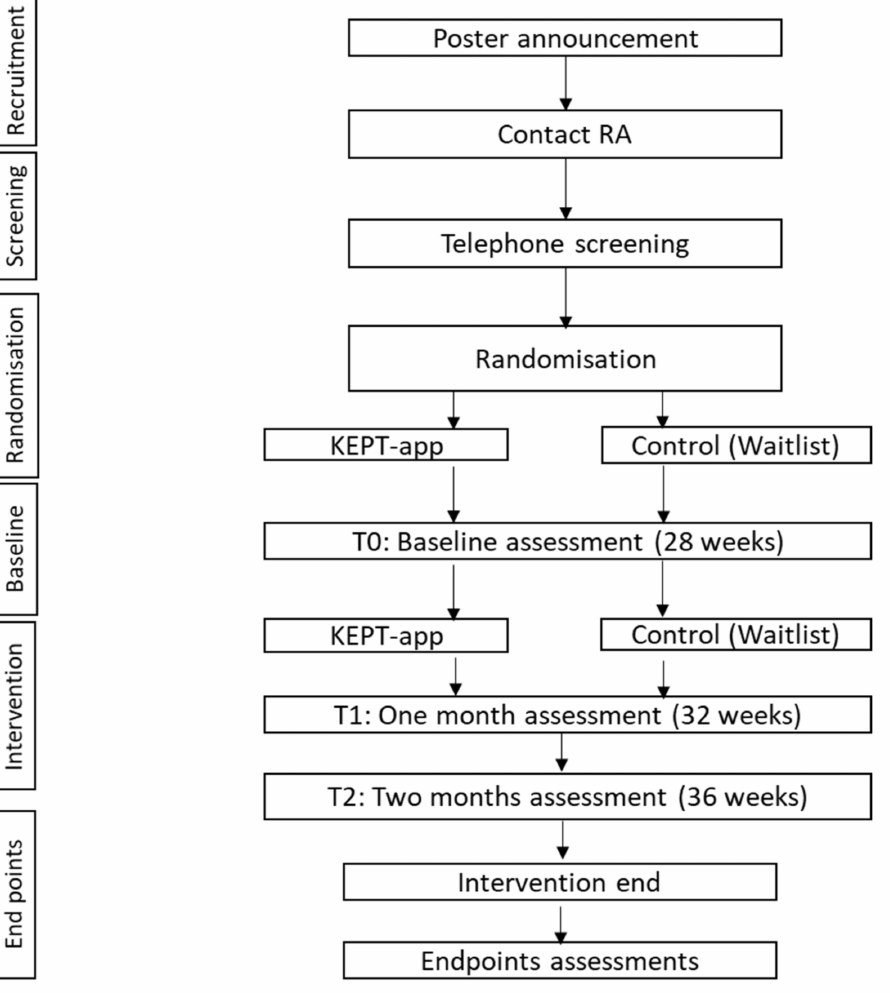
Figure 1. Pilot study